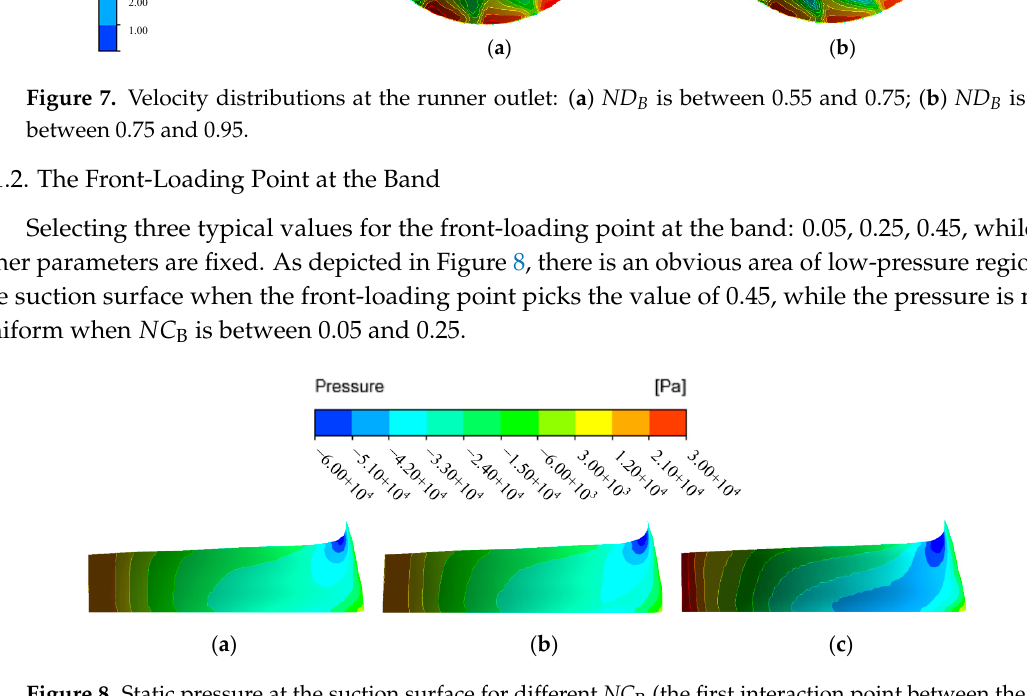
( c ) Figure 5. Three sets of mesh with different y plus distributions: ( a ) Mesh A with maximum y plus of 113; ( b ) Mesh B with maximum y plus of 158; ( c ) Mesh C with maximum y plus of 189. 3. Design Parameter Analysis 3.1. Blade Loading Parameters 3.1.1. The After-Loading Point at the Band Selecting three typical values for the after-loading point at the band: 0.55, 0.75, 0.95, while the other parameters are fixed. As depicted in Figure 6, the pressure of the suction surface gradually decreases and the area of the low-pressure region increases with the after-loading point moving backward. The pressure at the band near trailing edge is lower and the low-pressure area is larger. And the low-pressure area at the middle of the crown develops from nothing. Thus, the pressure gradient between the band and the crown increases, which gives the chance to the secondary flow development [11]. The lower the ND B is the smaller the low-pressure area is. ( a ) ( c ) Figure 6. Static pressure at the suction surface for different ND B (the second interaction point